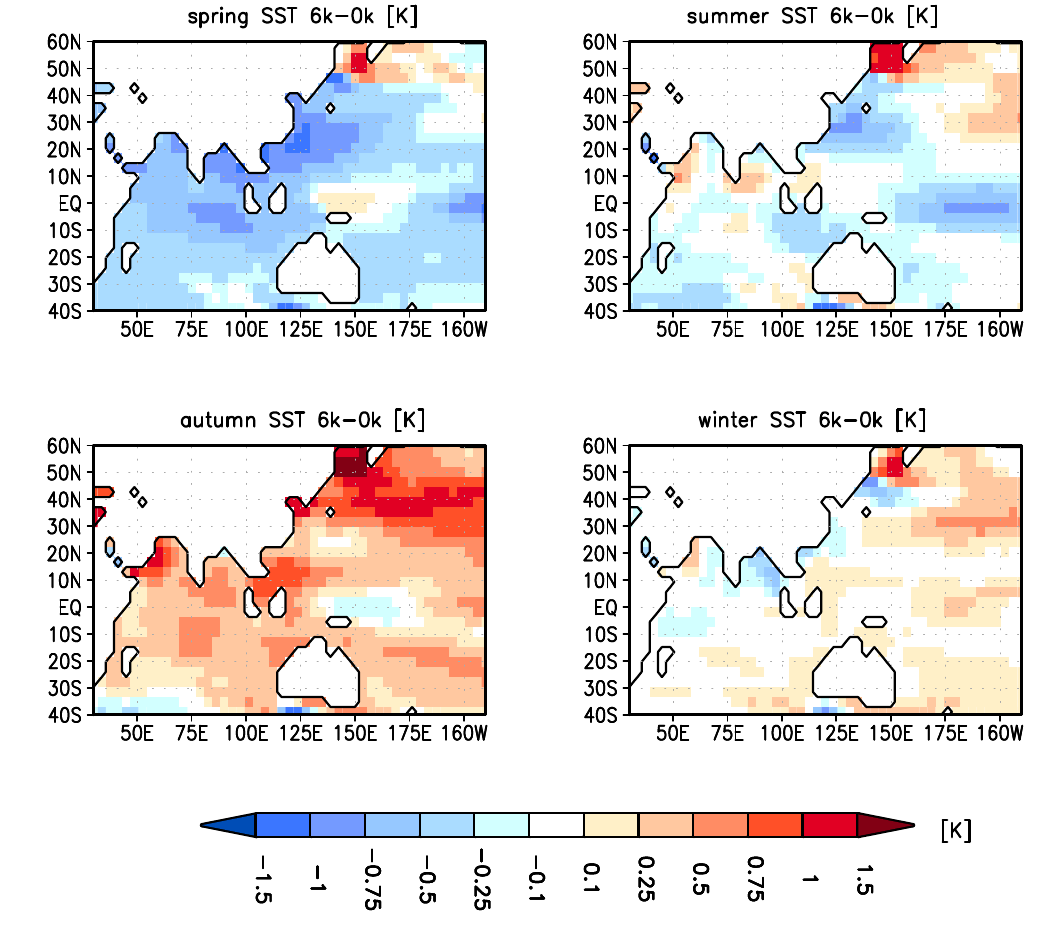
Fig. 7. Simulated differences in seasonal sea-surface-temperature [K] between mid-Holocene and present-day